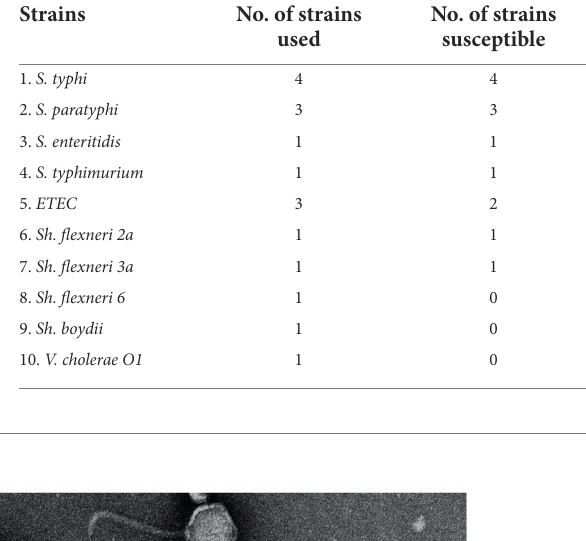
TABLE 1 Host range analysis of phage STWB21.